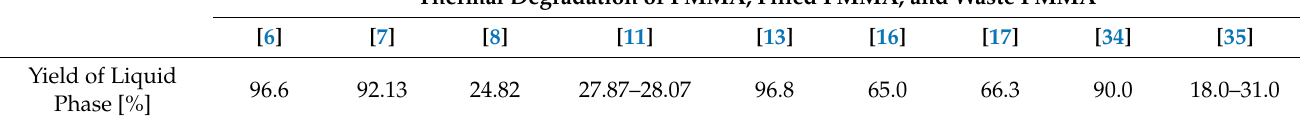
Table 3. Depolymerization of PMMA [7,8,11,13,34], filled PMMA [8,11,16,35], and waste PMMA [6,7,13,17,34], operating in batch [16,17,34], fixed bed reactor, and continuous [6–8,11,35], fluidized bed reactor, in semi-pilot [6–8,11,16,17], and laboratory scales [13,34,35]. Thermal Degradation of PMMA, Filled PMMA, and Waste